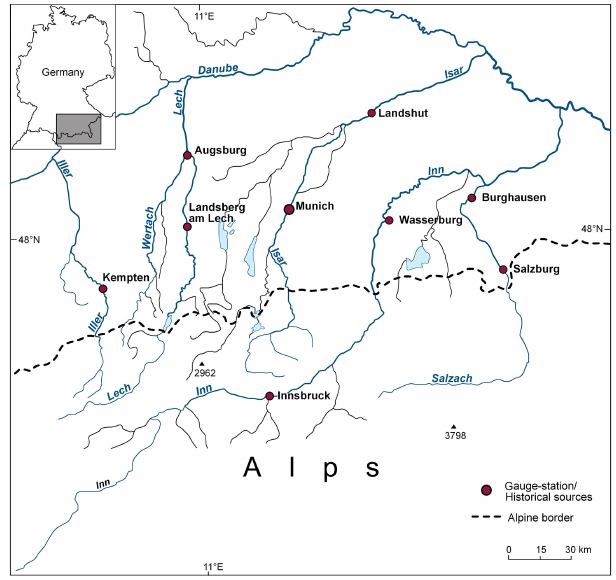
Figure 1. The investigation area Bavarian Foreland is bordered by the rivers Iller, Danube, Inn/Salzach and the Alpine bor- der (dashed line). Red spots indicate outstanding historical locations and